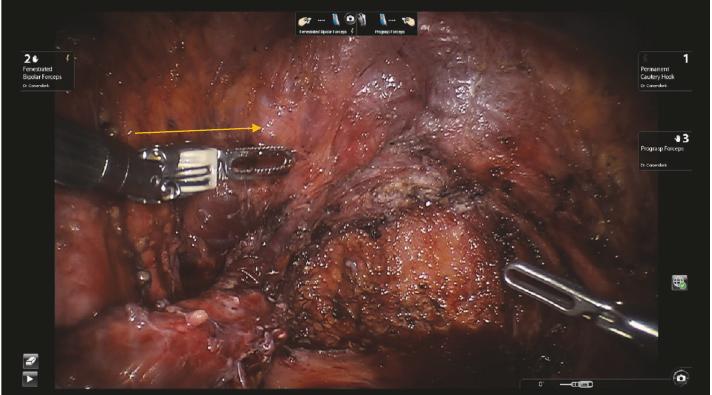
Figure 3: Left ureter following AmnioFix membrane placement. AmnioFix membrane identified by yellow arrow.